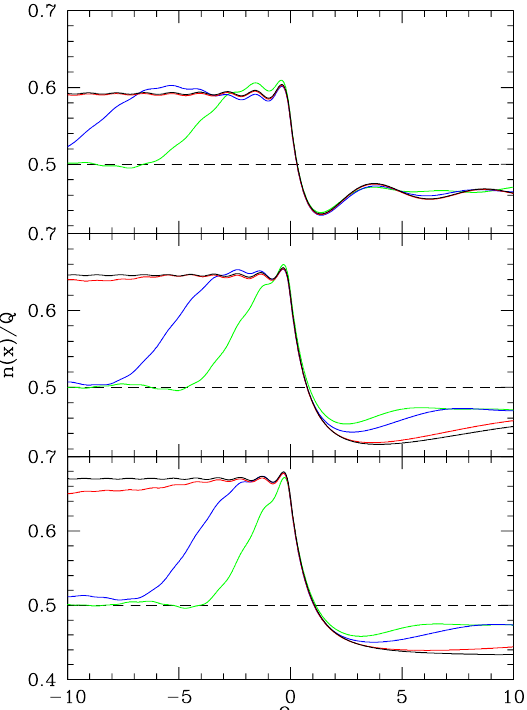
Q . Figure 7. Exact time evolution of the density profile for a right moving fluid with k F = π 2 The dashed line shows the initial condition. Green, blue and red lines refer to evolution times t = 5,10,50 respectively for k 0 = − 3 π Q (top panel), for k 0 = − 9 π Q (central panel) and for k 0 = − k F 20 10 (bottom panel). The black line shows the steady states determined analytically according to the prescriptions of Section 4. The corresponding velocity profiles at stationarity are shown in Figure 3 (right panels). The time unit is τ = m ¯ hQ 2